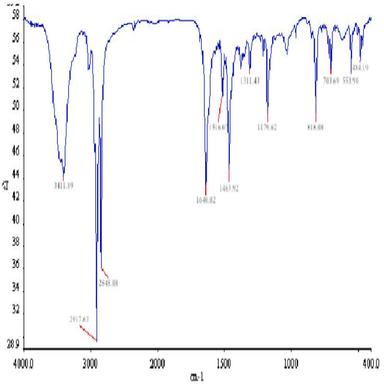
FTIR spectra of DMPI Crystalline (Product).